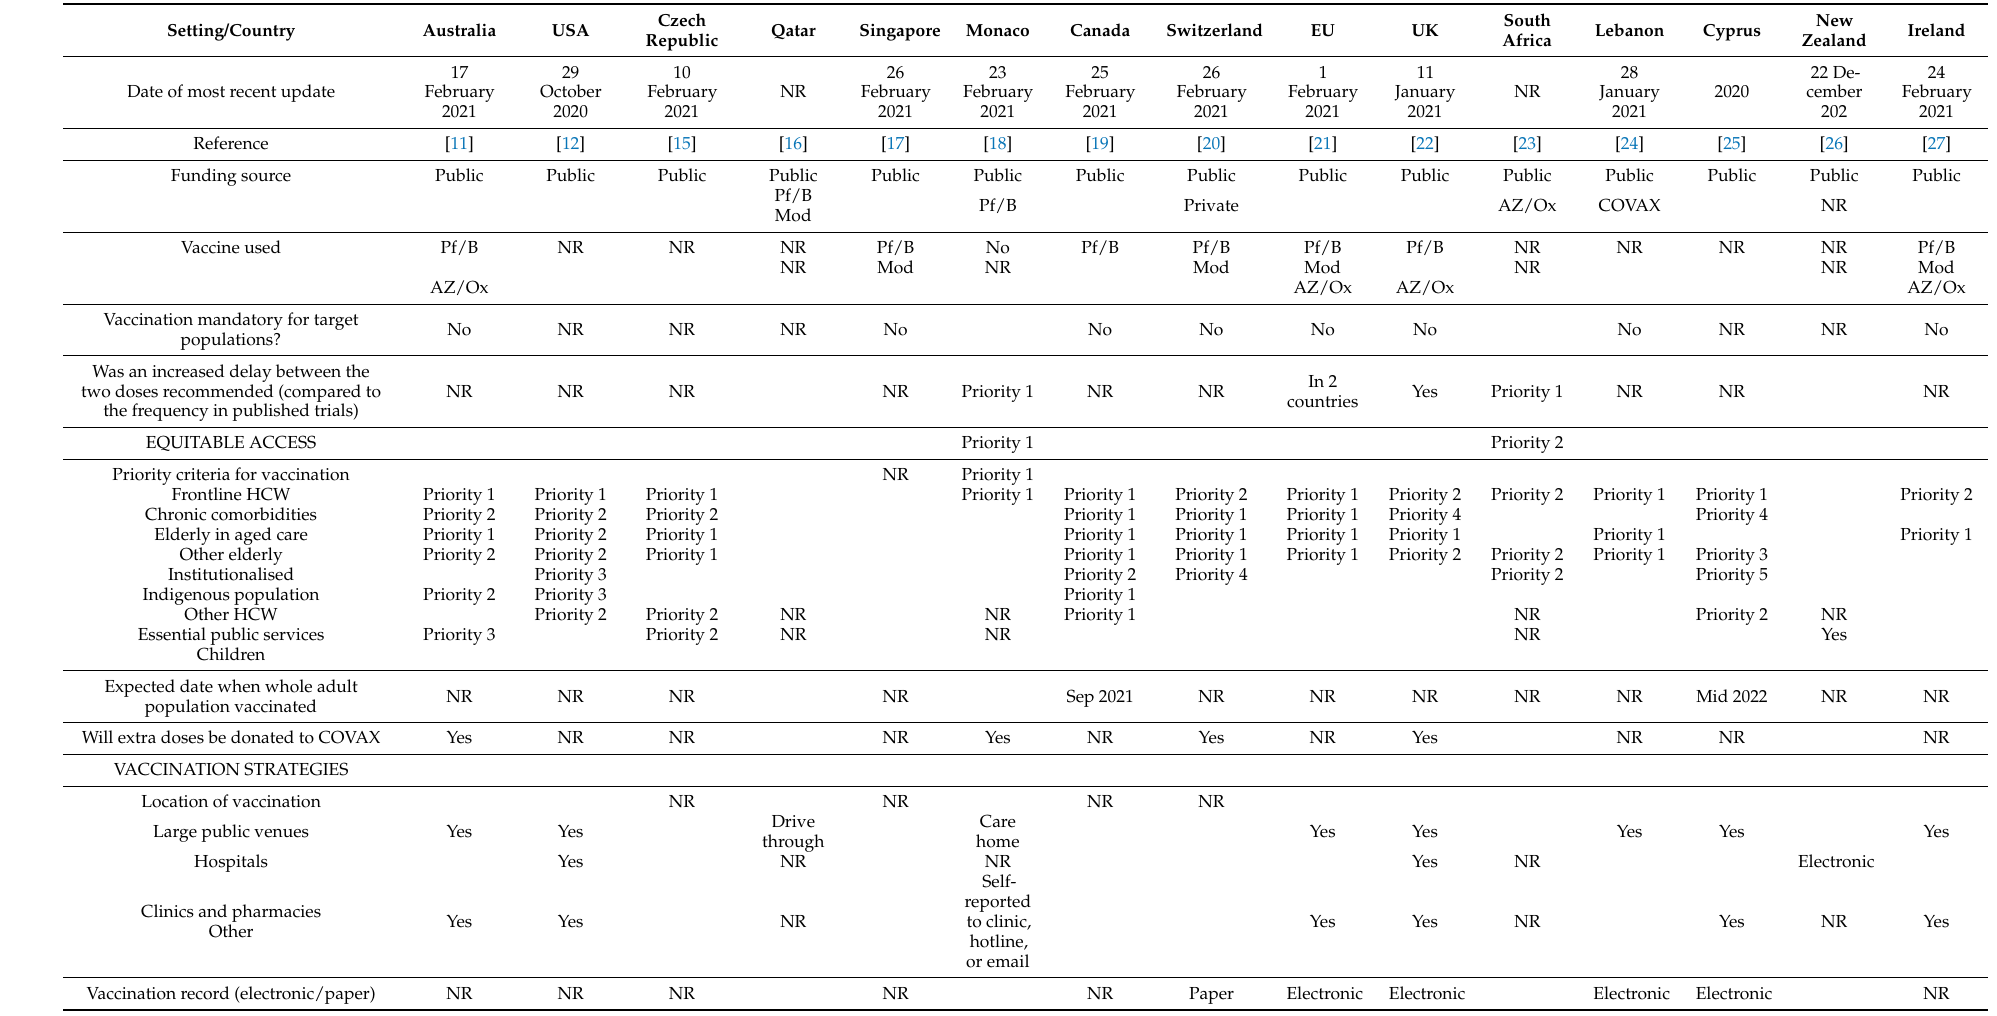
Table 1. Summary of publicly-available national policy documents for the implementation of mass-vaccination against